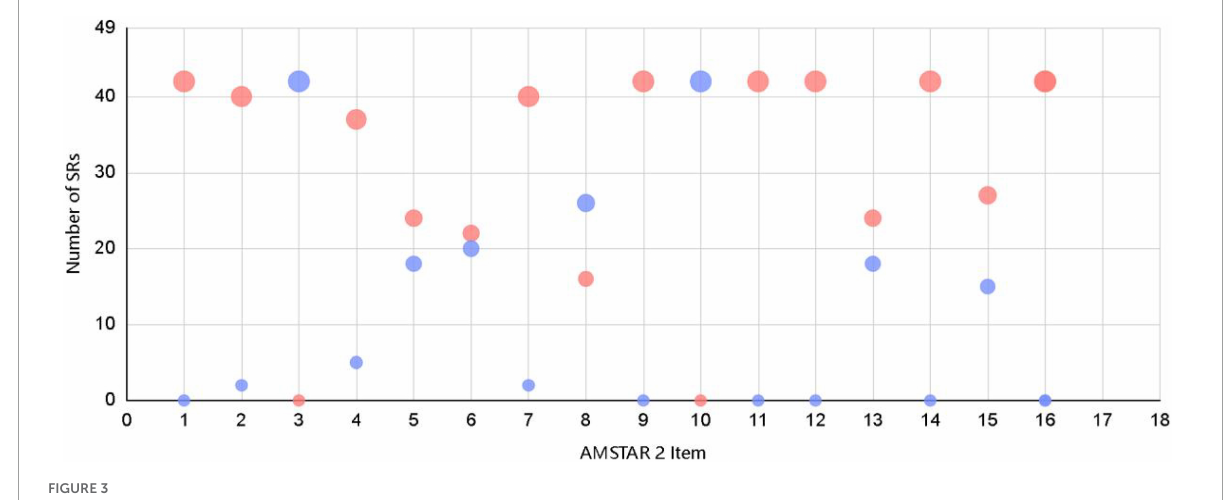
FIGURE3 The bubble plot of quality assessment